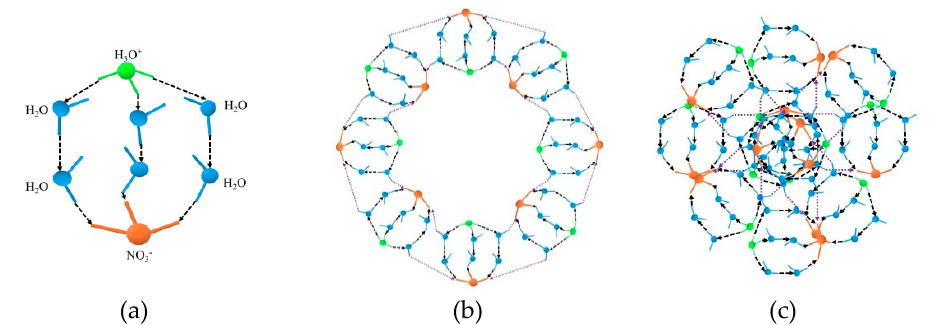
Figure 7. The growth process module of the supramolecular structure ( a ) → ( b ) → ( c ), produced in the reaction of acetone and nitric acid. ( a ) Initial structure generation. ( b ) chain polymerization reaction starts. ( c ) The chain polymerization reaction ends and becomes a supramolecular structure.